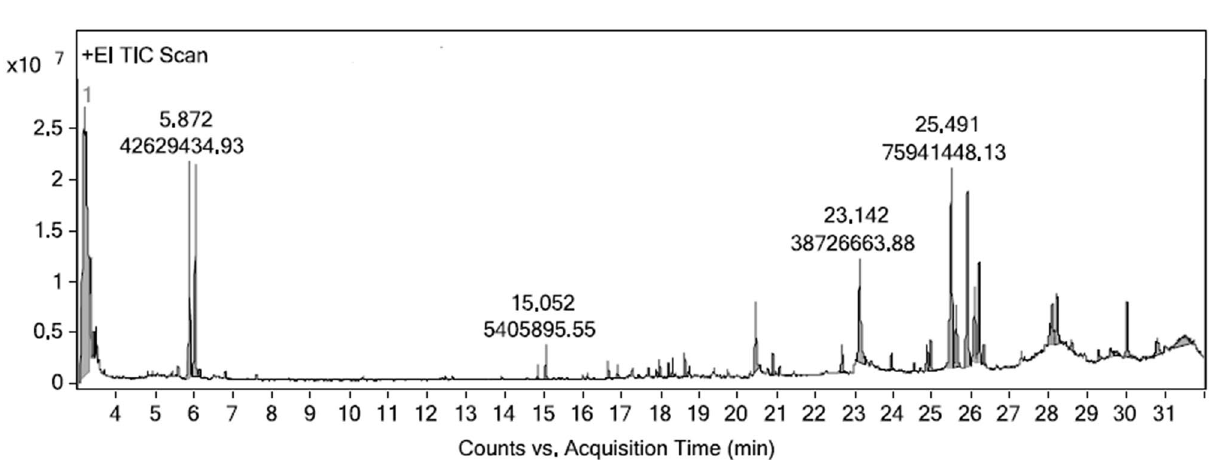
Figure 4. GC–MS/MS chromatogram of PC4 fraction (Acetone: methanol) of M. paniculata Hexane extract. The peaks represent the active compounds present in the PC4